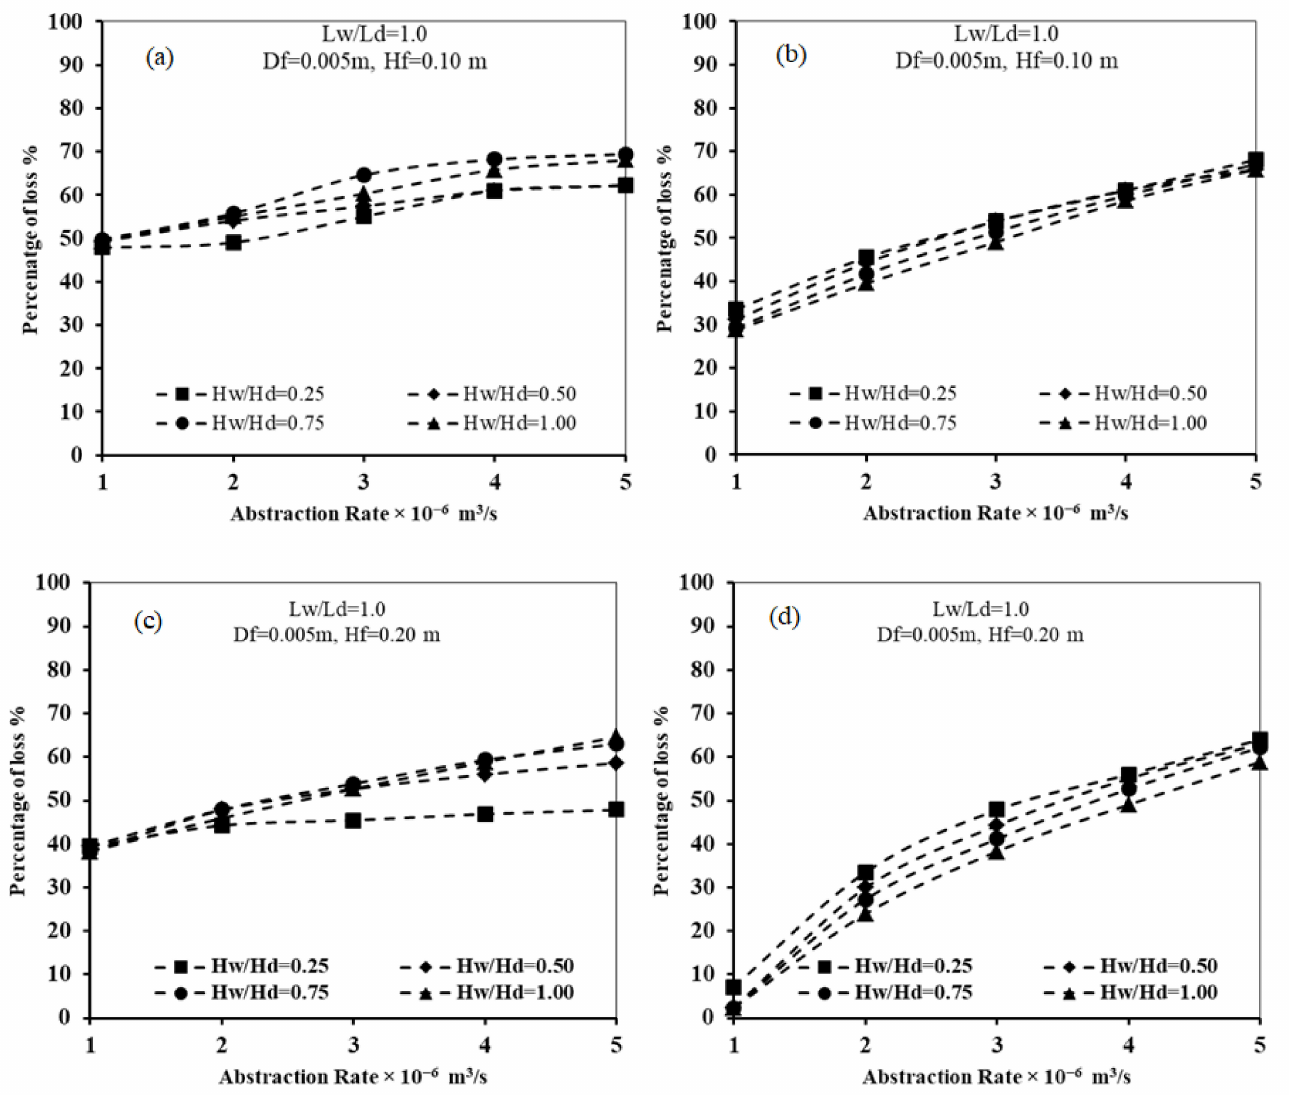
Figure 12. Relation between abstraction rate and loss of subsurface dam effectiveness for D F = 0.005 m and L w /L d = 1.0 for different values of subsurface dam location: ( a ) L d = 0.30, H f = 0.1 m ( b ) L d = 0.50, H f = 0.1 m ( c ) L d = 0.30, H f = 0.2 m, and ( d ) L d = 0.50, H f = 0.2